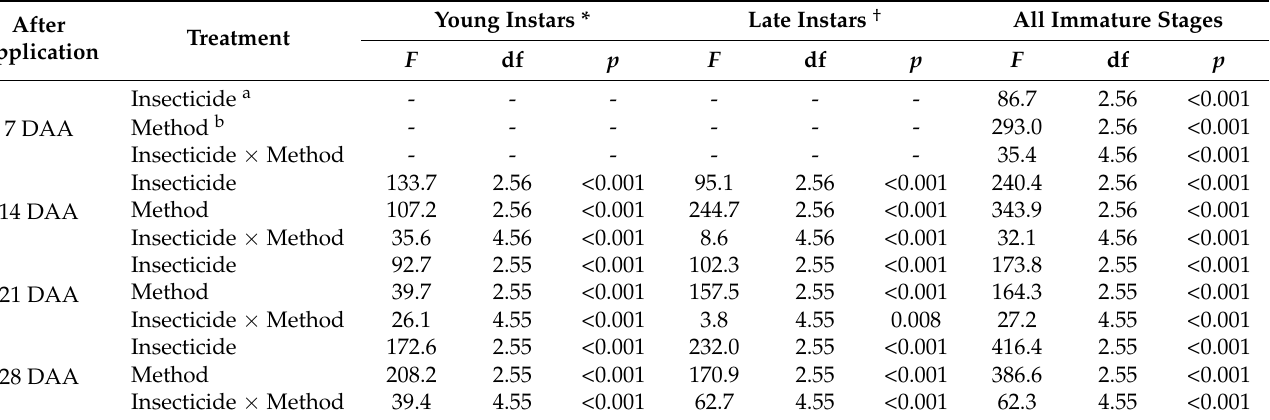
Table 1. Analysis of variance of B. tabaci immatures observed on poinsettia leaves after application of insecticides at three foliar spray or drench